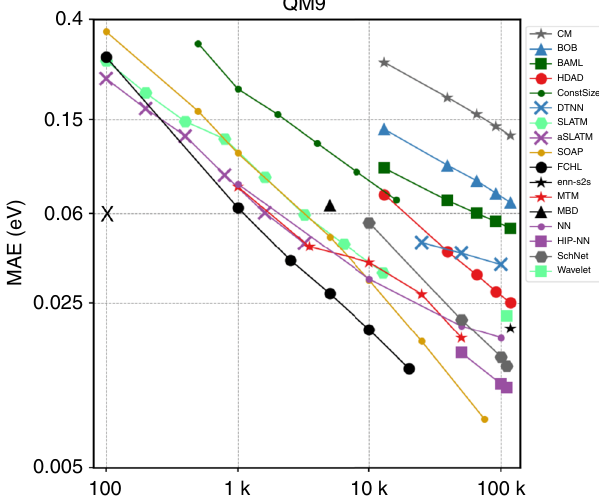
Fig. 2 Learning curves of atomization energies of organic molecules, showing out-of-sample prediction error (mean absolute error) decays with increasing number of training molecules drawn at random from QM9 dataset 26 . Models shown differ by representation and architecture. The black X denotes the "QM9 challenge'' of achieving 1 kcal/mol accuracy on the QM9 dataset using only 100 molecules for training 3 . Adapted from ref. 25 , Springer Nature